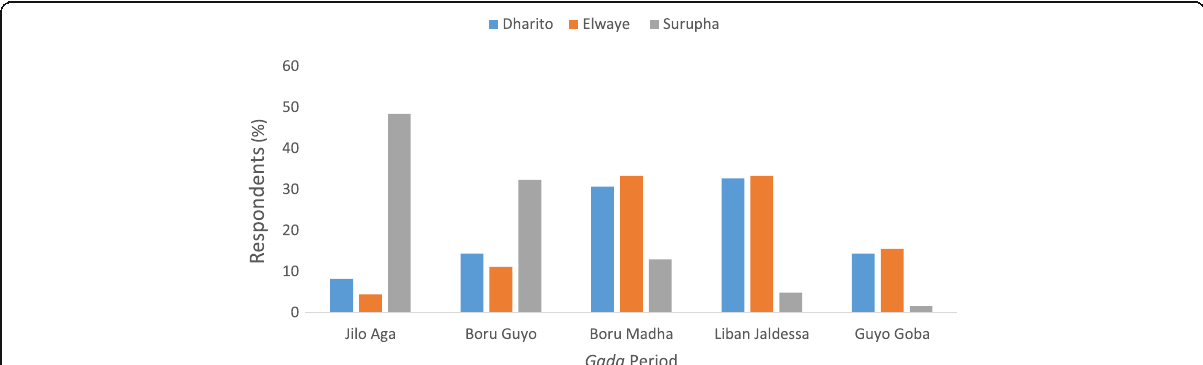
Fig. 4 Perceptions of pastoralists (%) regarding camel adoption and population trends in different Gada periods in the three kebeles in the study area in Borana, southern